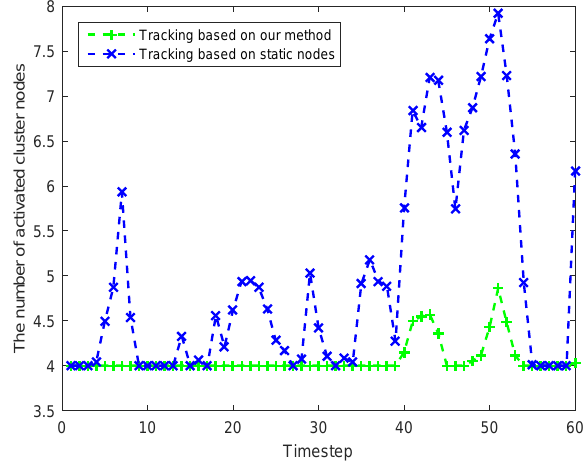
Figure 10. Comparisons of the number of activated cluster nodes in each timestep.